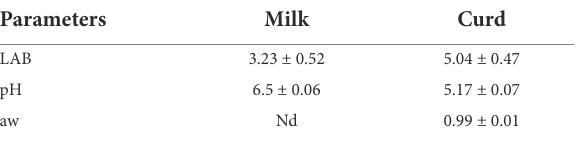
Nd, not determined. Data are the average of 2 values per 6 independent experiments